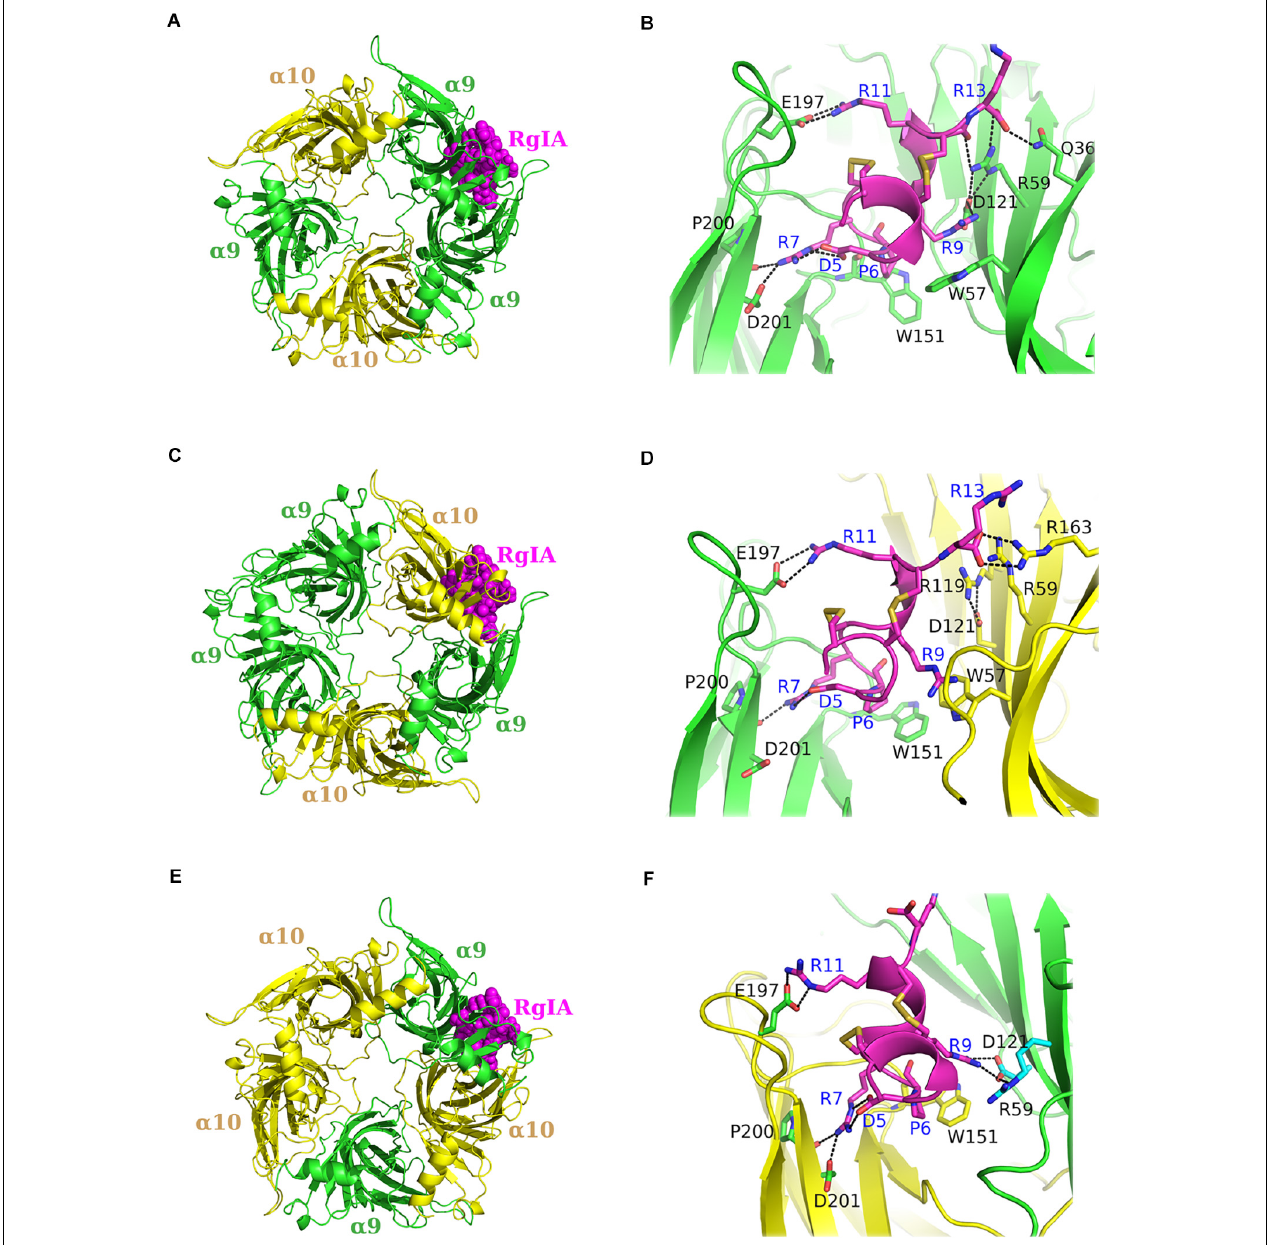
FIGURE 4 | Molecular dynamics (MD) models of α 9 α 10 nAChR-ECDs. (A,B) RgIA bound to the α 9( + )/ α 9( − ) interface and close view of interactions. (C,D) RgIA bound to the α 9( + )/ α 10( − ) interface and close view of interactions. (E,F) RgIA bound to the α 10( + )/ α 9( − ) interface and close view of interactions. α 9-ECD in green, α 10-ECD in yellow and RgIA in magenta. Labeled in blue are the RgIA-interacting residues and in black the interacting residues of α 9 or α 10-ECDs.